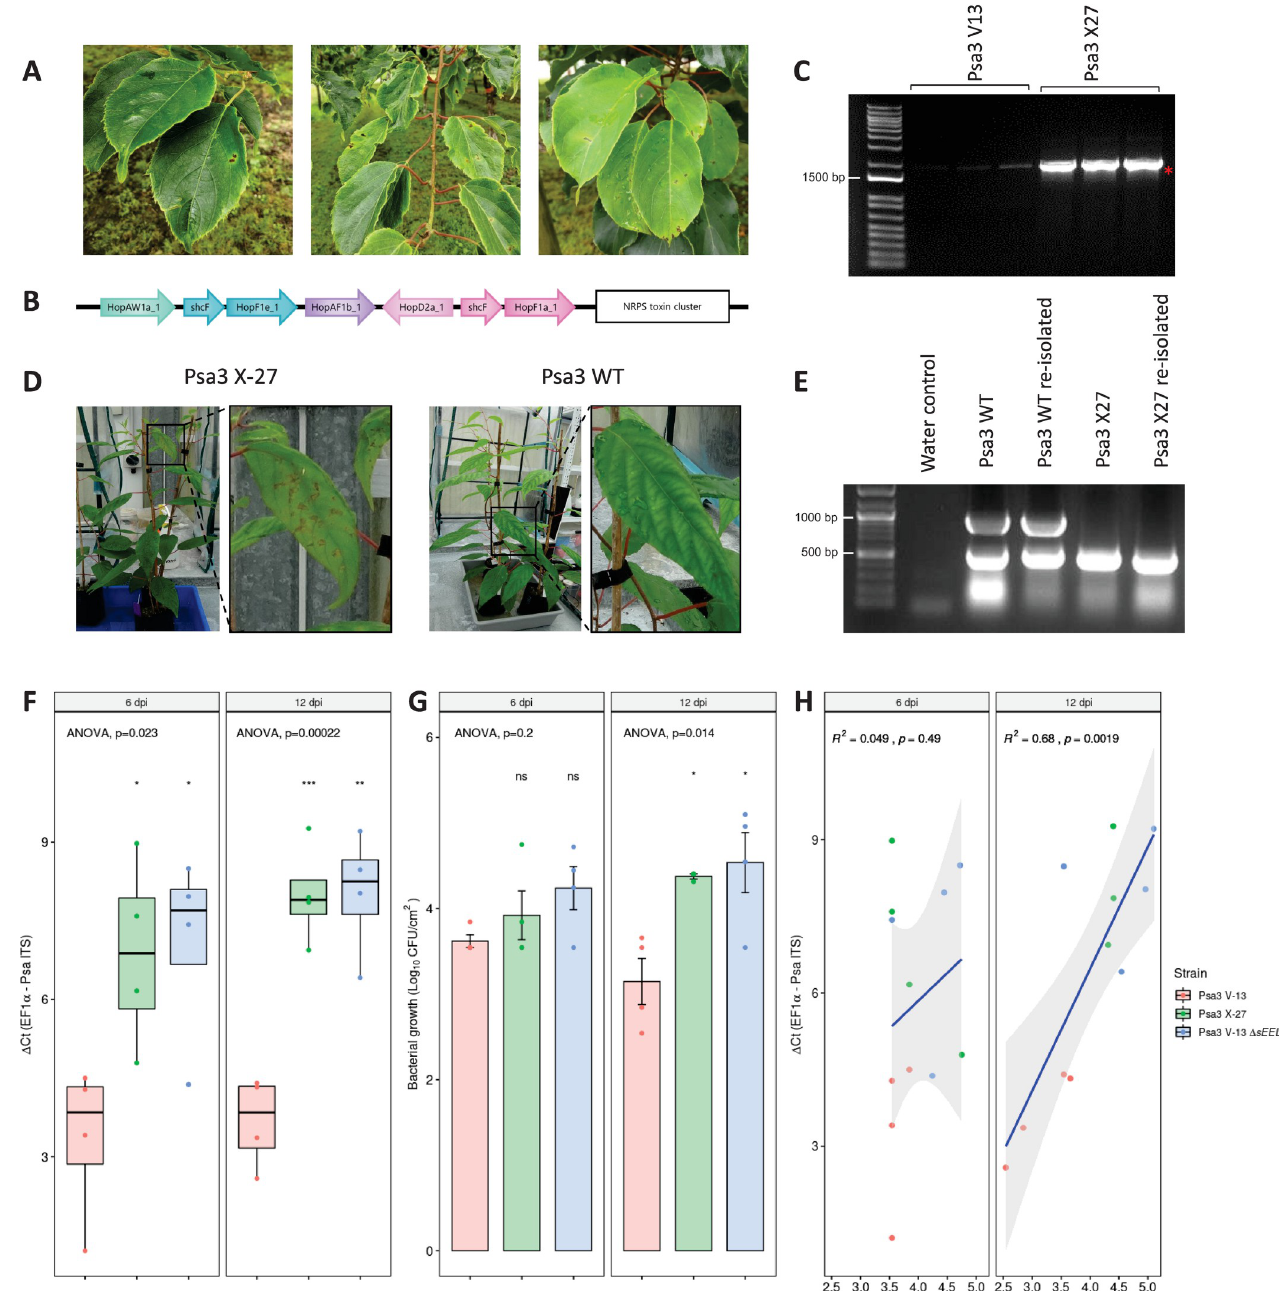
Fig 2. Pseudomonas syringae pv. actinidiae biovar3 (Psa3) isolated from symptomatic Actinidia arguta plants has a deletion in the exchangeable effector locus that escapes host recognition. (A) Psa leaf spot symptoms on commercial A . arguta ‘HortGem Tahi’ plants in the Plant & Food Research Te Puke Research Orchard. (B) The Psa3 X-27 gene deletion spans the effectors hopAW1a , hopF1e , hopAF1b , hopD2a , hopF1a , and the non-ribosomal peptide synthase (NRPS) toxin cluster. The Psa3 X-27 gene deletion was identified through whole-genome sequencing on an Illumina HiSeq platform and confirmed by PCR. (C) Three colonies of Psa3 ICMP 18884 (V13) or Psa3 X-27 were used as templates for PCR across the deletion boundary Psa-X27 (1804 bp) and the band indicating deletion (red asterisk) confirmed by Sanger sequencing. The weak non-specific band in Psa V13 samples are present in all samples. DNA marker is 1Kb Plus DNA Ladder from Thermo Fisher (NZ) with 1500 bp band indicated. (D) Psa3 X-27 or Psa3 10627 (WT) were sprayed onto potted A . arguta AA07_03 plants and photographs of symptoms taken 6 months post-infection. (E) Psa3 10627 (WT) and Psa3 X-27 re-isolated from infected leaves and confirmed by multiplex PCR for Psa-ompP1 (492 bp) and the EEL effector gene hopF1e (883 bp). DNA ladder is 100bp DNA Marker from Zymo Research (USA) with 1000 bp and 500 bp bands indicated. (F-H) A . arguta AA07_03 plantlets were flood-inoculated with Psa3 V-13, Psa3 X-27, and Psa3 V-13 Δ sEEL at approximately 10 6 cfu/mL. Bacterial growth was quantified at 6 and 12 days post-inoculation by qPCR Δ Ct analysis F and plate count quantification G . (F)